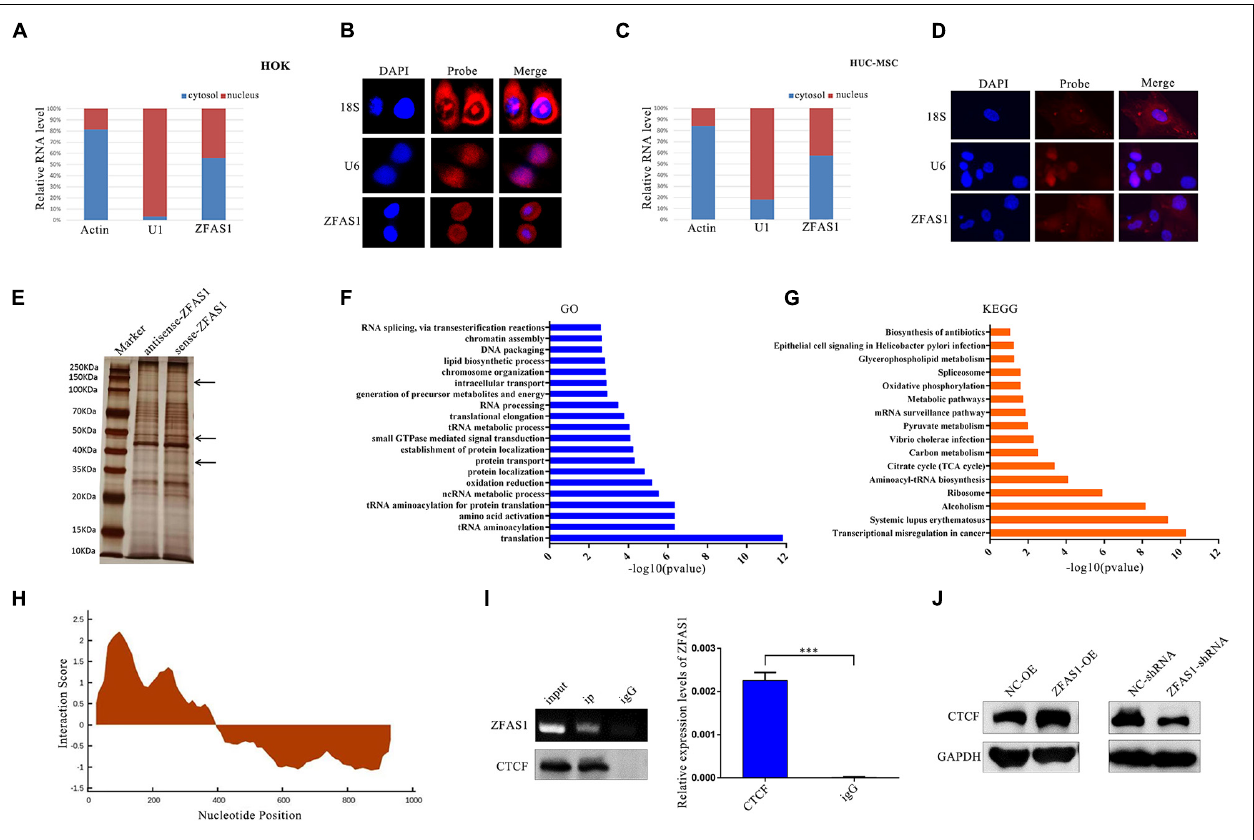
FIGURE 5 | ZFAS1 regulated the protein level of CCCTC-binding factor (CTCF) through binding with CCCTC-binding factor (CTCF) protein. (A,C) Nucleus cytoplasm separation indicated that ZFAS1 was distributed in both the nucleus and cytoplasm of human oral keratinocyte (HOK) cells and human umbilical cord mesenchymal stem cells (HUC-MSCs). (B,D) RNA fluorescence in situ hybridization (FISH) assays indicated that ZFAS1 was distributed in both the nucleus and cytoplasm of HOK cells and HUC-MSCs. Left, DAPI was used to stain the nuclei (blue); middle, red fluorescence was from the biotin fusions; right, the merged image. (E) Proteins retrieved from the ZFAS1 pull-down assay were analyzed by sodium dodecyl sulfate–polyacrylamide gel electrophoresis (SDS-PAGE). The arrows indicate the unique proteins in the sense-ZFAS1 group compared with antisense-ZFAS1 group. (F,G) The gene ontology (GO) and Kyoto Encyclopedia of Genes and Genomes (KEGG) pathways enriched in these proteins from RNA pull-down assay. (H) The predicted binding sites of ZFAS1 with CTCF by catRAPID. The interaction score indicated the possibility of binding. (I) RNA immunoprecipitation (RIP) assay of ZFAS1 with anti-CTCF antibody. ZFAS1 and CTCF interaction in CTCF-RNA precipitates was revealed by nucleic acid gel (top left panel) and qPCR assays (right panel). Bottom left panel indicates that the CTCF protein was pulled down by anti-CTCF antibody. (J) ZFAS1 positively regulated CTCF protein levels by western blotting (WB). Values are mean ± SEM, n = 3, *** P <